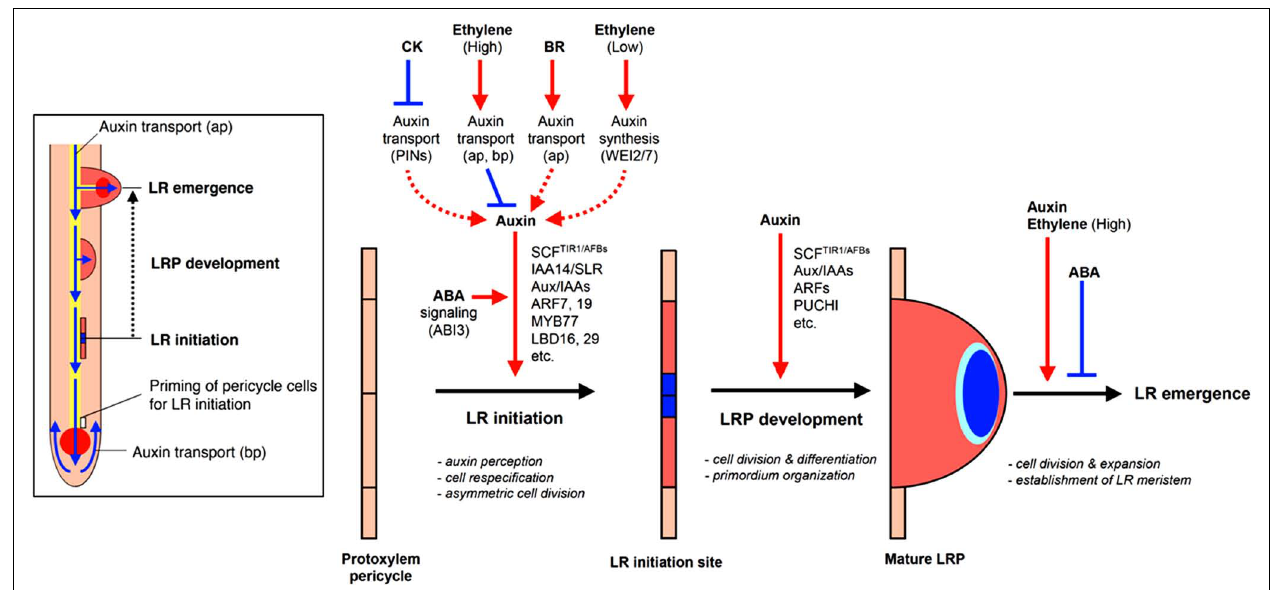
FIGURE 2 | Hormonal and genetic control of lateral root formation in Arabidopsis . LR formation is a three-stage process consisting of LR initiation, LRP development, and LR emergence. LR initiation is positively regulated by auxin but negatively regulated by CK and high concentrations of ethylene [high concentrations of exogenous 1-aminocyclopropane-1-carboxylic acid (ACC)].The polar auxin transport with a balance of influx and efflux in both acropetal and basipetal directions is necessary for LR initiation and setting up auxin gradient to organize LR primordium (LRP; blue color in LR initiation site and primordium). CK inhibits auxin maxima by altering the expression of PINs, thereby inhibiting auxin gradient for LR initiation. High concentrations of ethylene or exogenous ACC, an ethylene precursor, inhibited LR initiation by